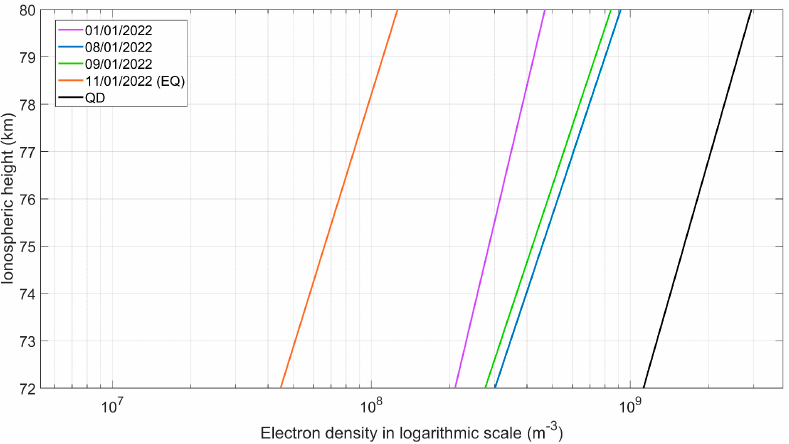
Figure 15. Altitude profile of ionospheric ED around the time of SRT obtained from ISR–UWA path with respect to the 2022 Cyprus EQ. The y -axis and x -axis denote the ionospheric height in km and the ED in logarithmic scale, respectively. “QD” and “EQ” lines represent the variation of normal days and the EQ day, respectively.